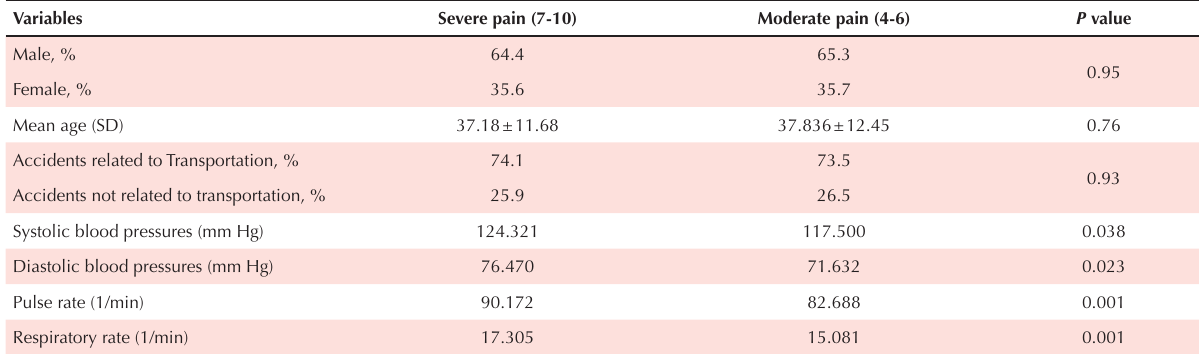
Table 1. Comparison of baseline characteristics between the two groups (patients with severe and moderate pain) Variables